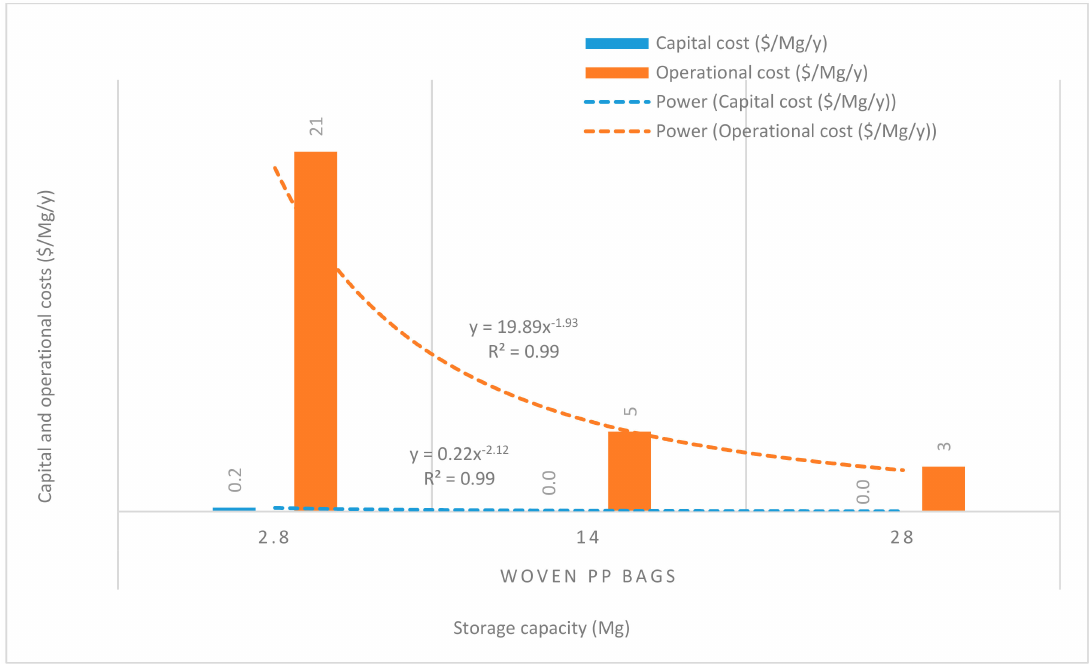
Figure 12. Economies of scale of capital and operational costs ($ / Mg / y) of using woven polypropylene bags